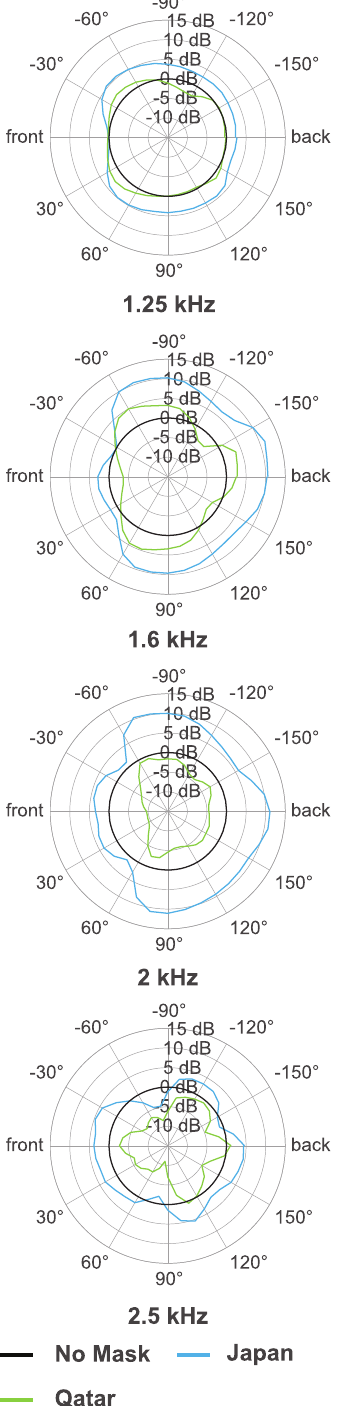
Figure 6. Polar plots of the sound radiation for the transparent masks Japan and Qatar normalized by the sound without (no) masks for speci fi c frequencies (1.25 kHz, 1.6 kHz, 2 kHz and 2.5 kHz). Front indicates the position of the KEMAR head with the mouth pointing at the microphone, back indicates the back of the head pointing towards the